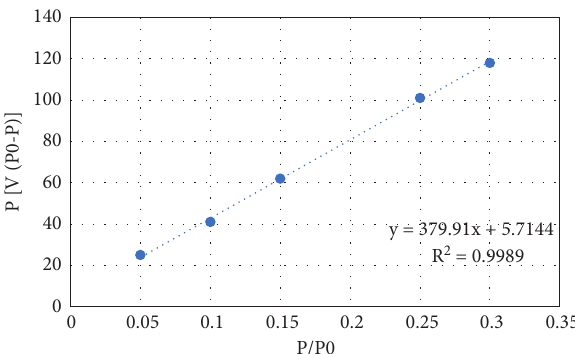
Figure 1: Multipoint BET method for measuring the specific surface area. Fitting experimental data with equation (1) was performed by plotting the left-hand side of equation (1) versus P / P 0 to obtain C and V m BET parameters.